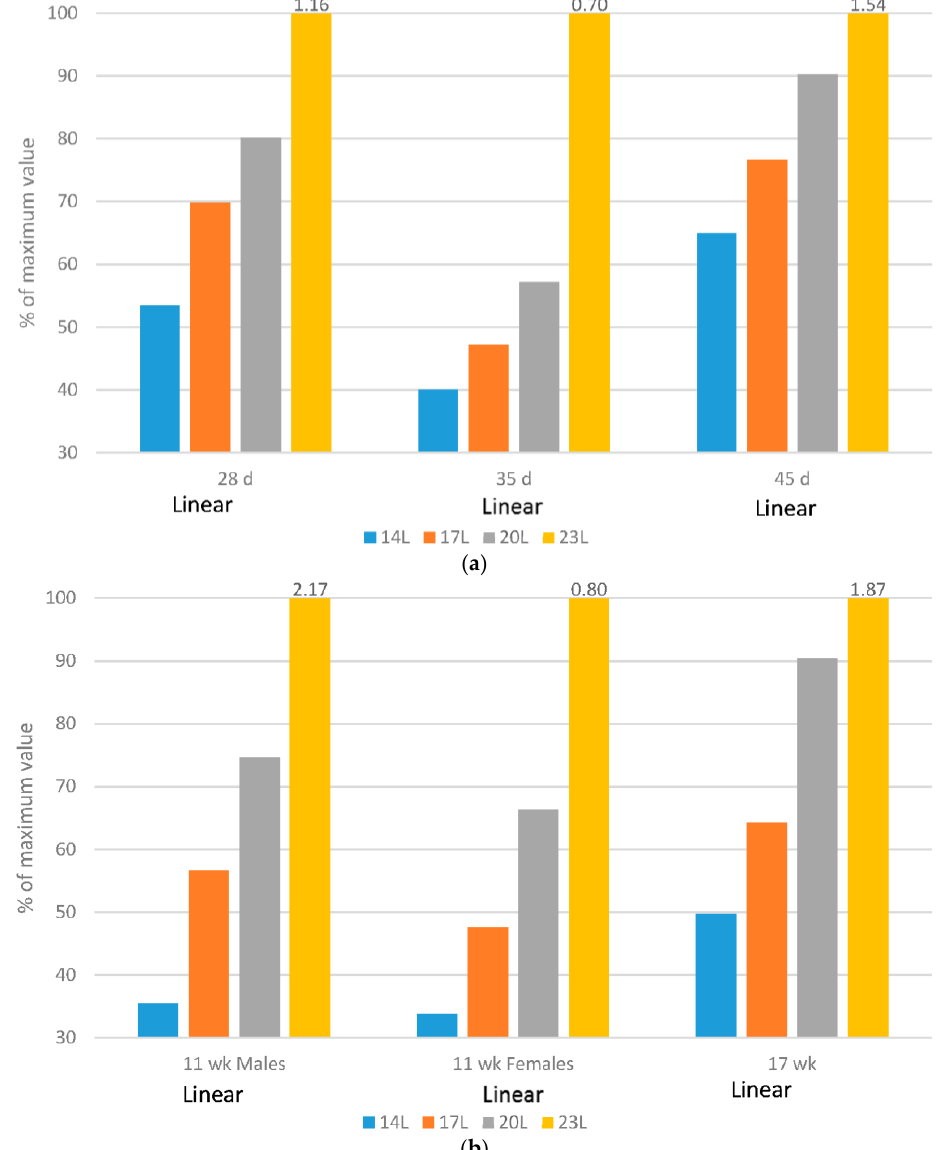
Figure 4. Daylength effects on mobility (measured by gait score). ( a ) Comparison of broiler mobility based on average gait score under four daylength photoperiods at three age ranges, with data expressed as a percentage of the maximum value within each age; ( b ) Comparison of turkey mobility based on average gait score under four daylength photoperiods at three age ranges, with data expressed as a percentage of the maximum value within each age.